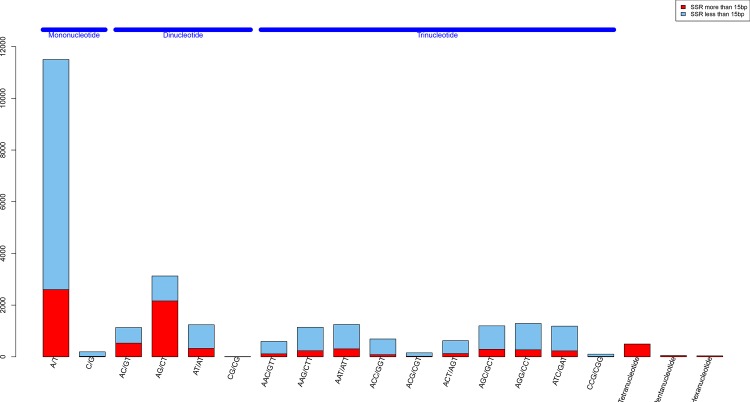
Distribution of simple sequence repeat (SSRs) nucleotide classes among different nucleotide types found in M. nipponense sequences.X-axis: Distribution of SSR types, Y-axis: The number of different SSR types.